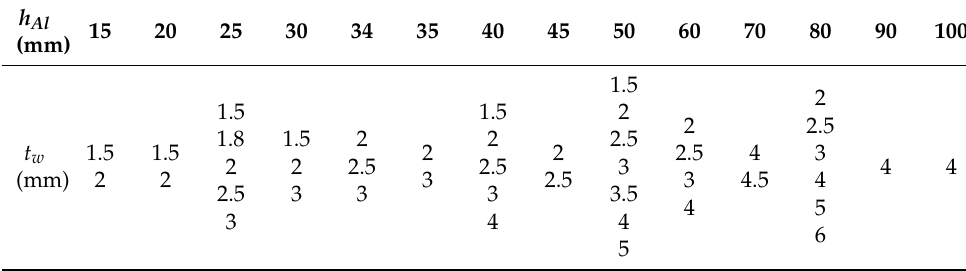
Table 2. Sizes of the available Al SHS